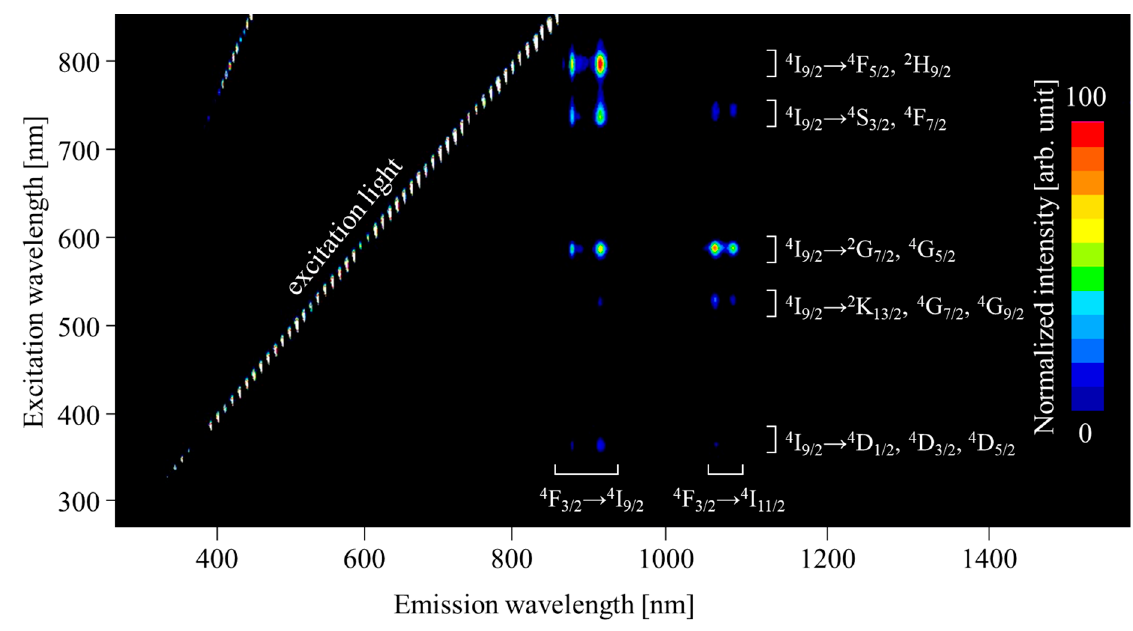
Figure 3. A PL contour spectrum of 1% Nd-doped LaMgAl 11 O 19 . Red and blue indicate high and low emission intensity, respectively.